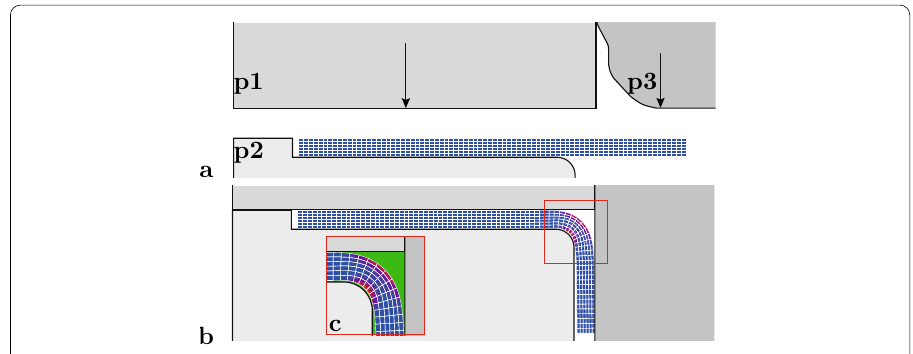
Fig. 11 Two stage deep-drawing and stamping process before ( a ) and after ( b ) deep-drawing. The depicted tools are the upsetting punch p1, the deep-drawing punch p2 and the deep-drawing ring p3. The green area in the detailed view ( c ) covers the target space with a 100% material filling Table 2 Material data published by [13] for DC04 steel including elasticity parameters and isotropic hardening parameters for the Hockett–Sherby material model Elastic parameters Young’s modulus E = 210,000 [MPa] Poisson’s ratio ν = 0.3 [–] Parameters for the Hockett–Sherby hardening function (cid:8) (cid:7) = σ ∞ + [ σ − σ ∞ ]exp σ ( (cid:7) a (cid:7) p b p ) 0 Initial yield stress σ 0 = 185 . 2 Infinite yield stress Hardening